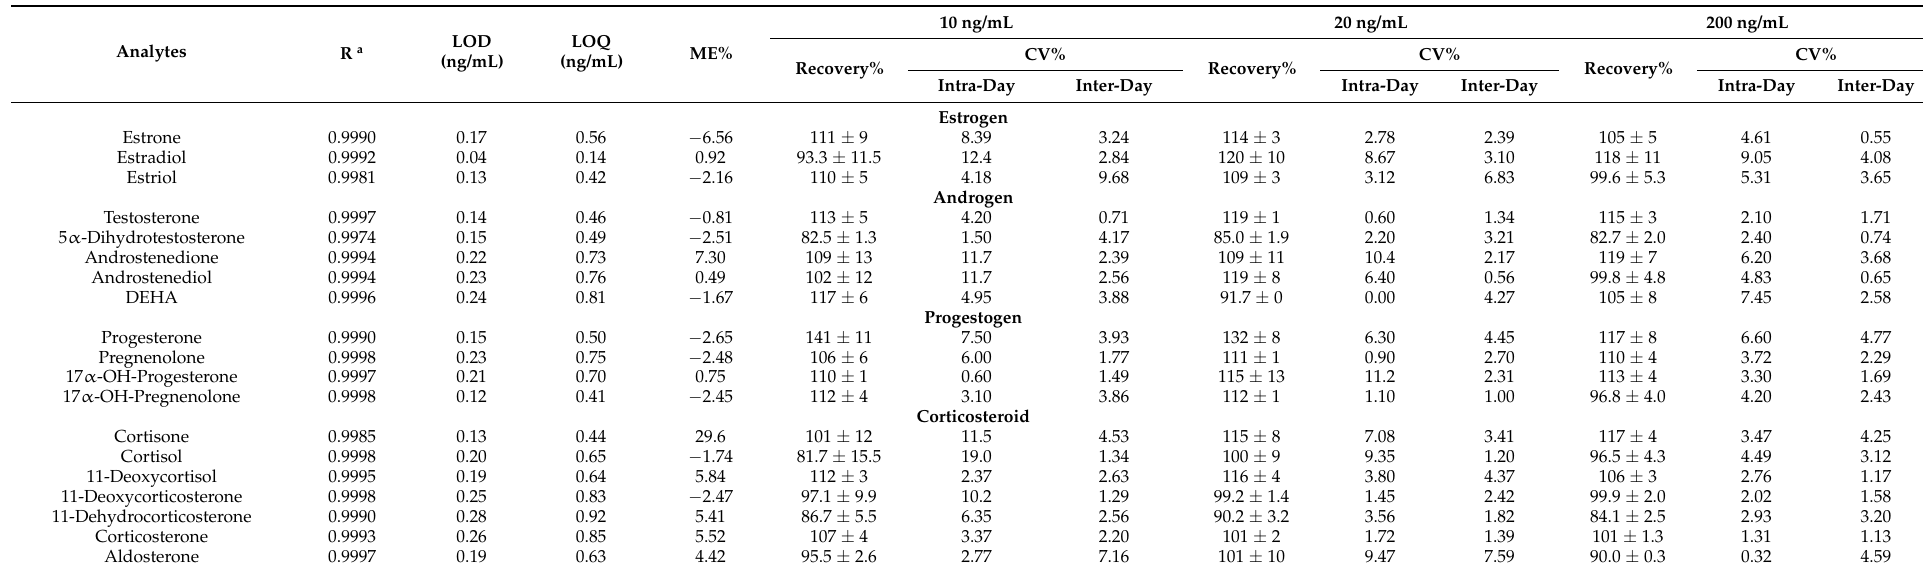
Table 2. Method validation parameters for the analysis of 19 steroid hormones in human